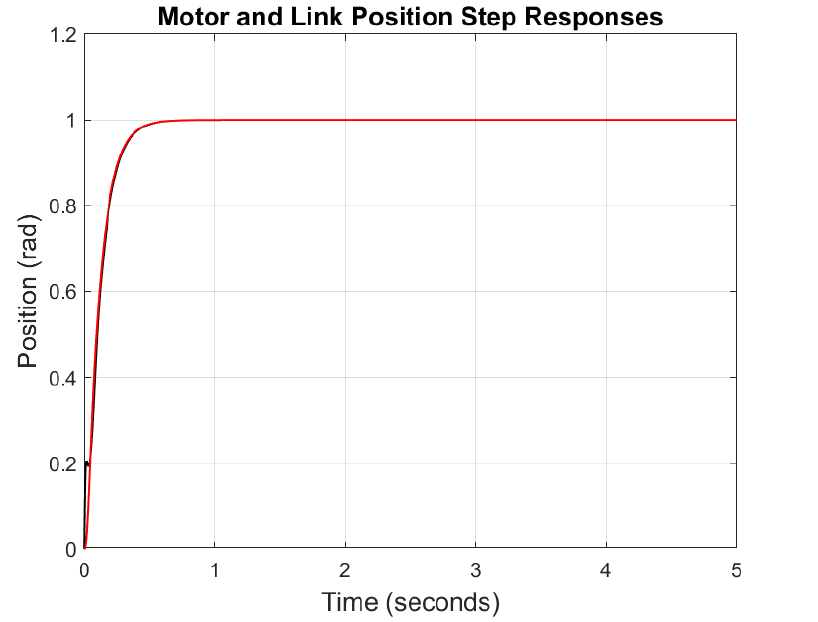
Figure 14. Position Motor and Link time responses—Black line: Motor; Dashed Red line: